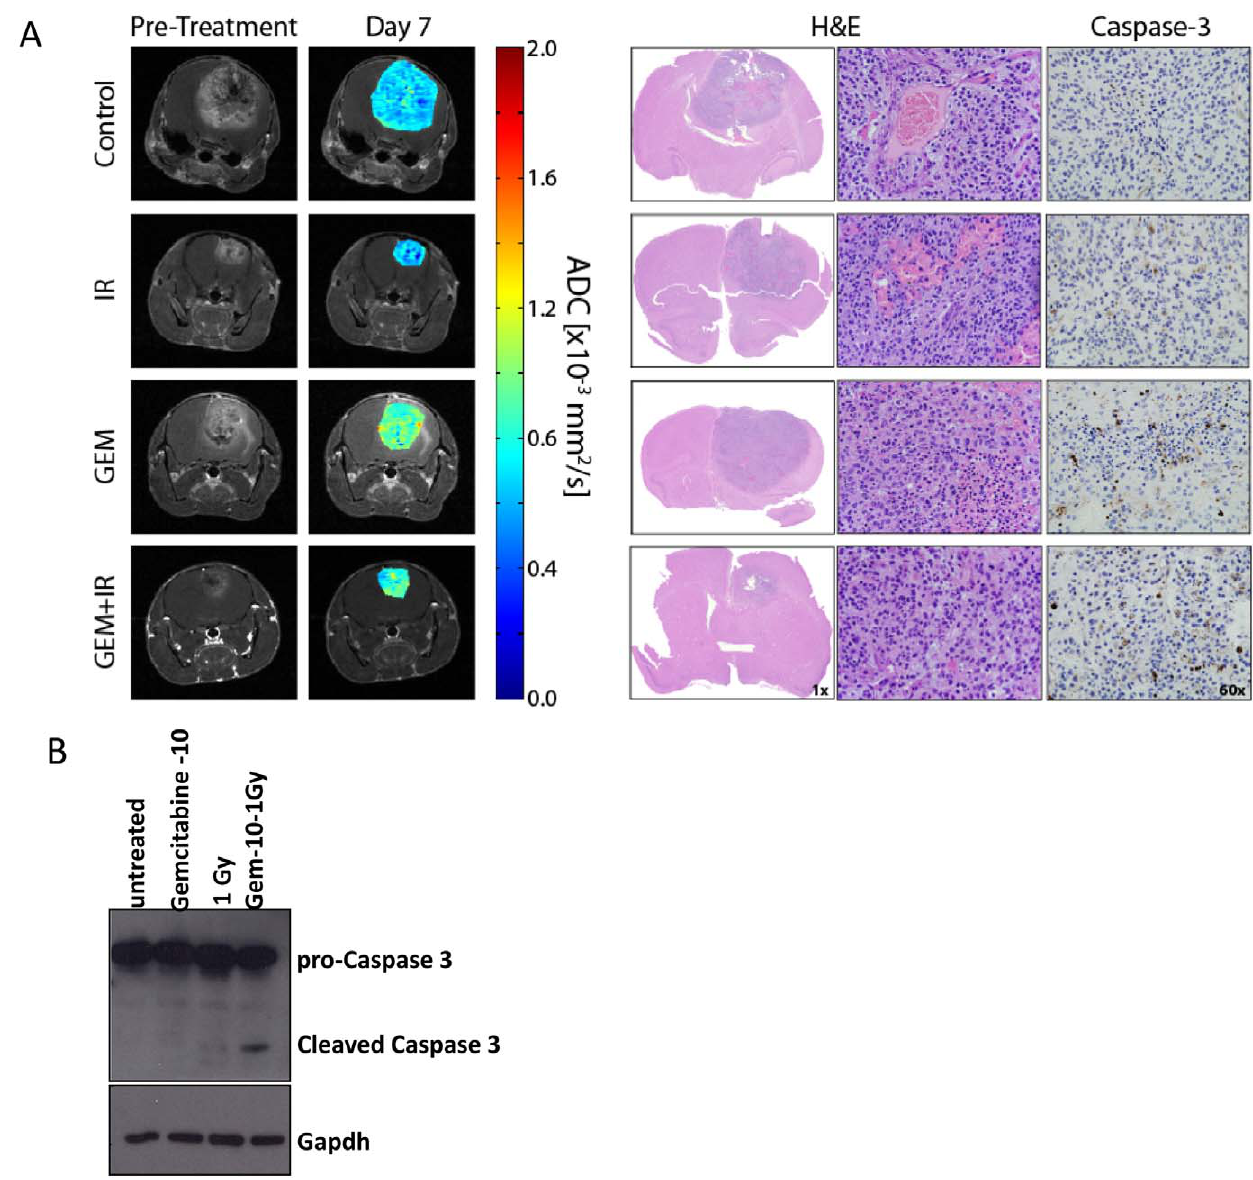
Figure 6. MR and histological images and western blots are presented from representative animals in Study2 treatment groups. (A) MRI data consists of anatomical contrast-enhancing T1-weighted images and ADC maps. Histological stains provide information on tumor cellularity (H&E) and apoptosis (caspase-3). All data were acquired at day 7 post-treatment initiation. (B) Tumor tissue from animals left untreated or treated with GEM, IR and GEM + IR at day two post-treatment initiation was assessed for cleaved Caspase 3. Western blot of representative animal tissue is shown and proper loading of protein samples was ensured by probing for Gapdh.